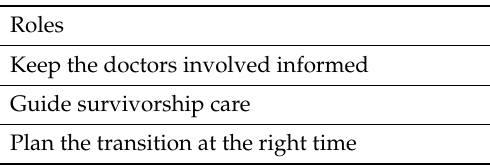
Table 2. Role of the